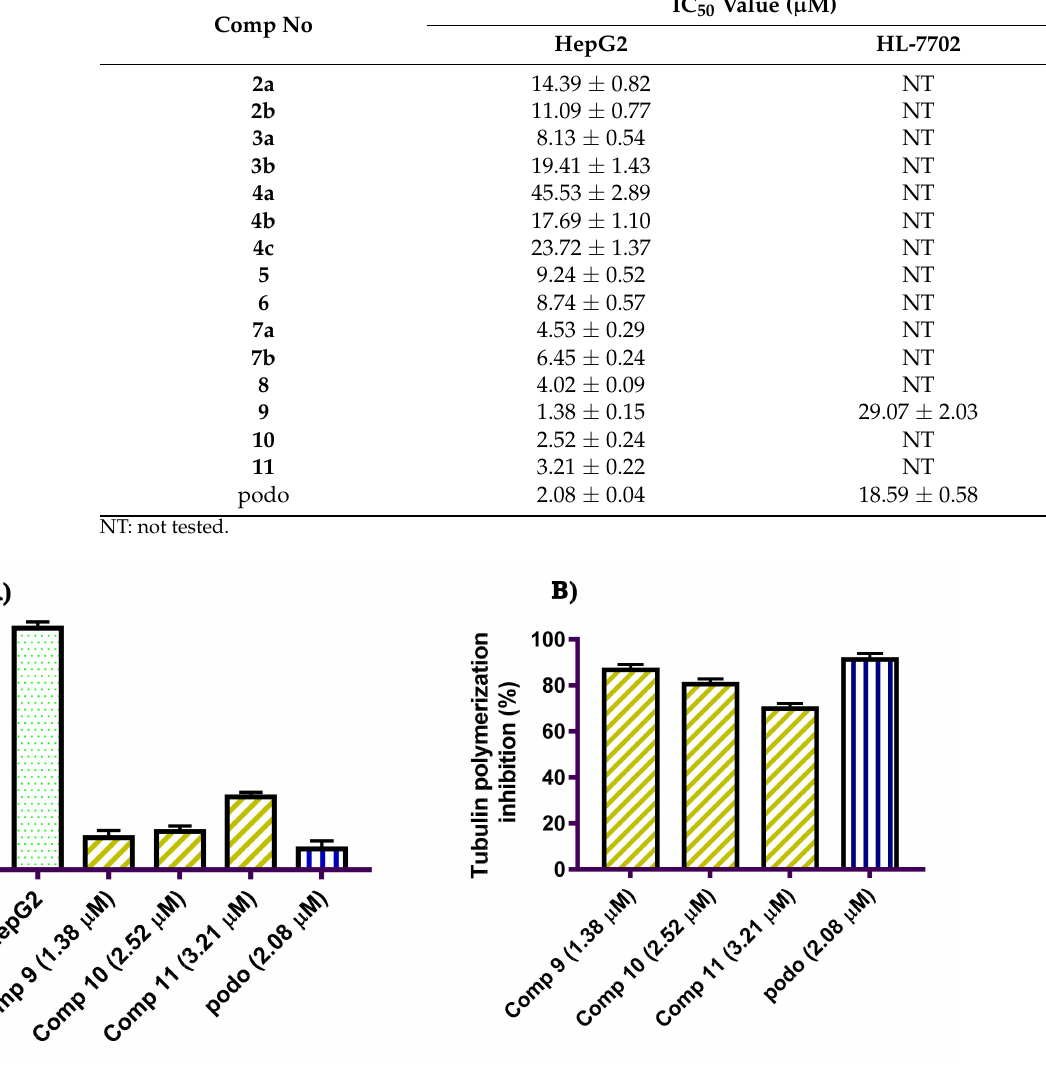
Figure 2. Compounds 9 , 10 , and 11 inhibited β -tubulin in HepG2 cells. ( A ) HepG2 cells were treated with 1.38, 2.52, 3.21, and 2.08 µ M of compounds 9 , 10 , 11 , and podo, respectively, and tubulin percentage was determined by ELISA assay. ( B ) β -Tubulin polymerization inhibition percentage induced by compounds 9 , 10 , and 11 compared to podo at their IC 50 concentration ( µ